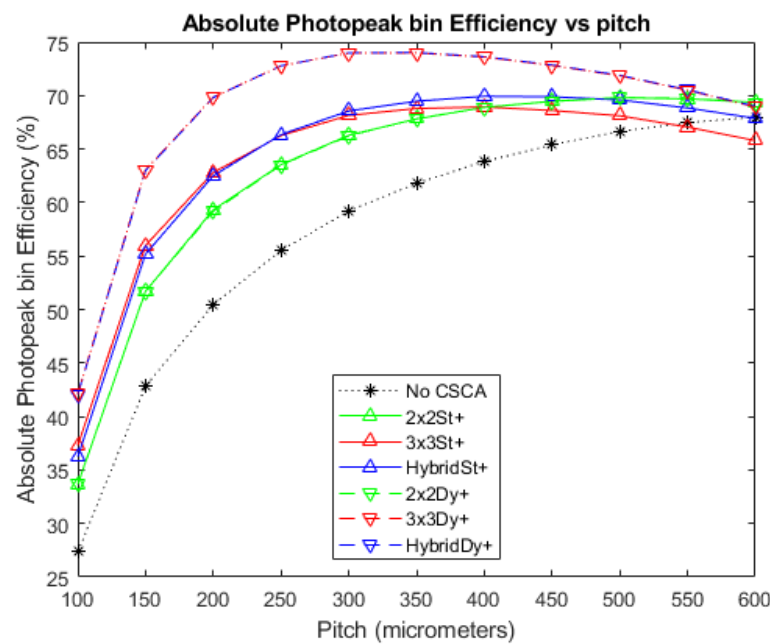
Figure 8. A plot of APE versus pixel pitch at an incident photon flux of 10 6 photons mm −2 s −1 . The dynamic Hybrid and dynamic 3 × 3 CSCAs perform indistinguishably according to this metric, resulting in significant overlap. Similarly, the 2 × 2 dynamic and static CSCAs overlap almost entirely at this flux level. The case where no CSCA is applied is also shown as a reference.